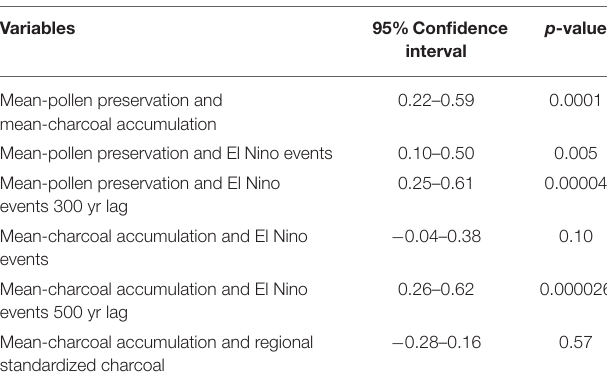
TABLE 2 | Summary of correlation analyses and